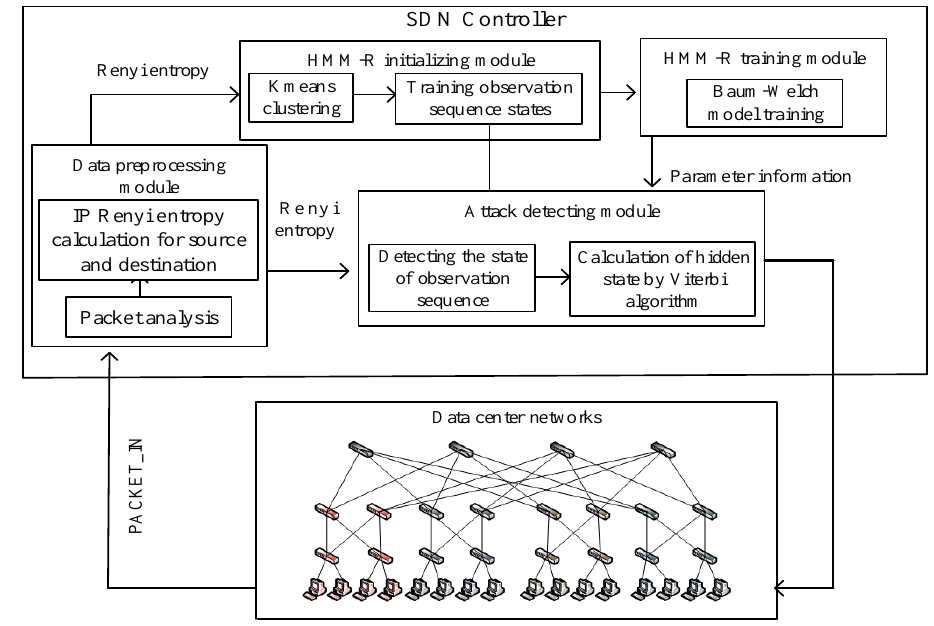
Figure 1. Architecture of HMM-R detection algorithm.